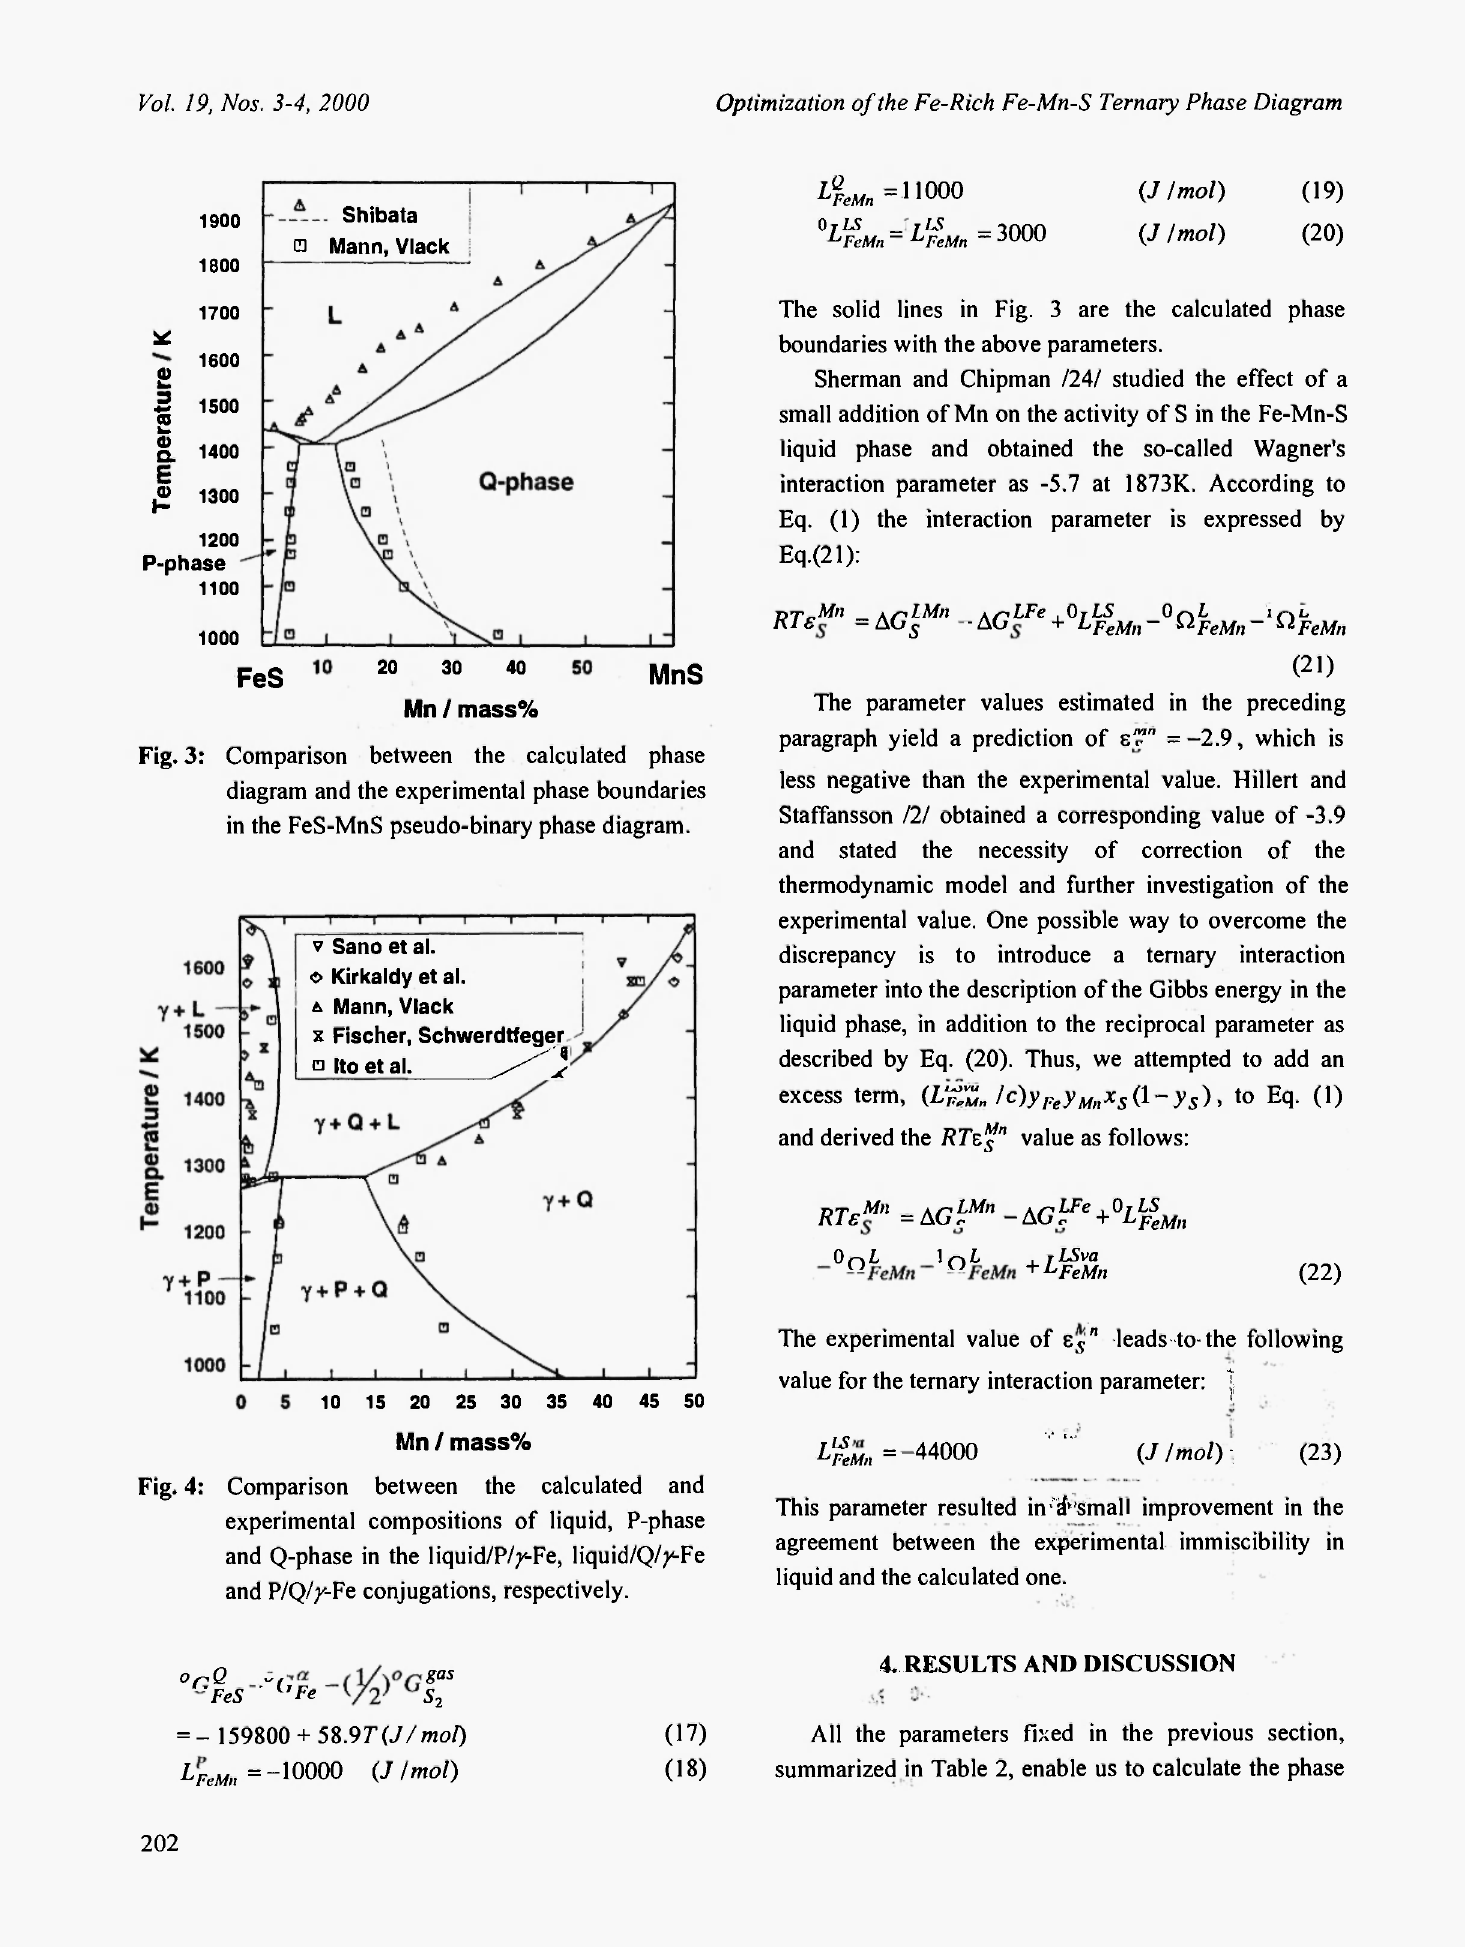
Fig. 3: Comparison between the calculated phase diagram and the experimental phase boundaries in the FeS-MnS pseudo-binary phase diagram.